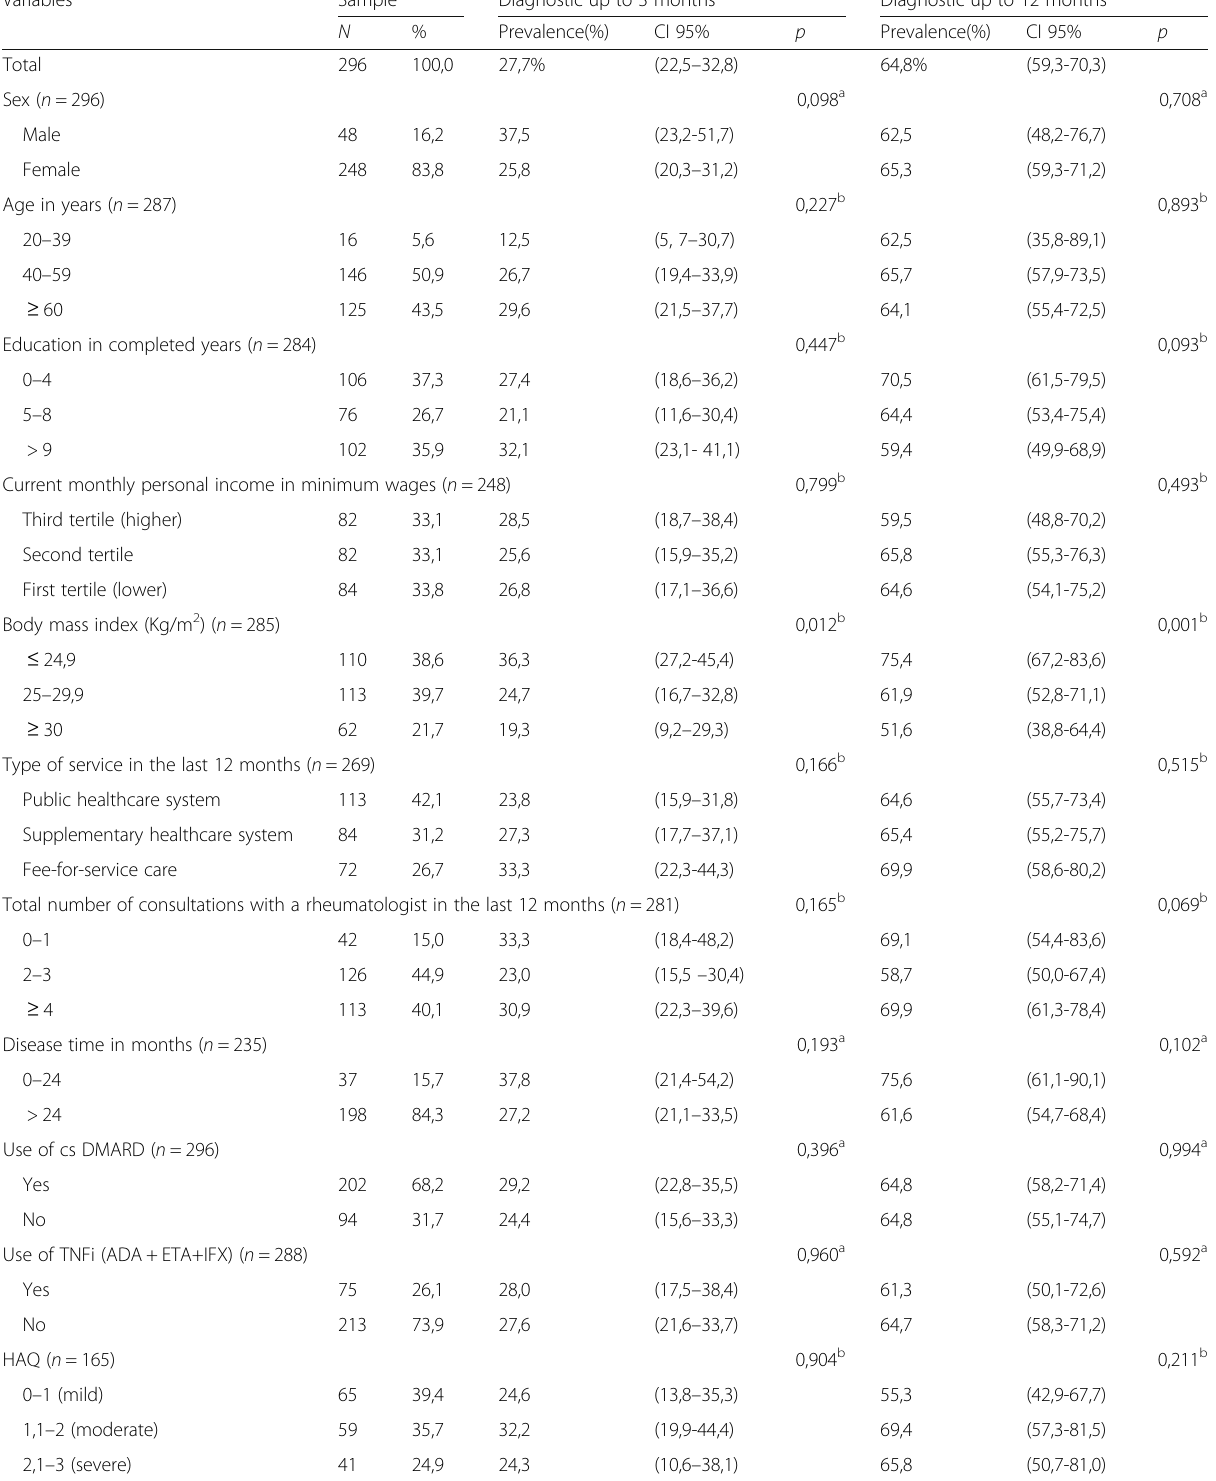
Table 1 Description of the sample and the prevalence of the diagnostic time of up to 3 and 12 months of symptons according to the independente variables in patients with rheumatoid arthritis of Blumenau, Santa Catarina, Brazil,